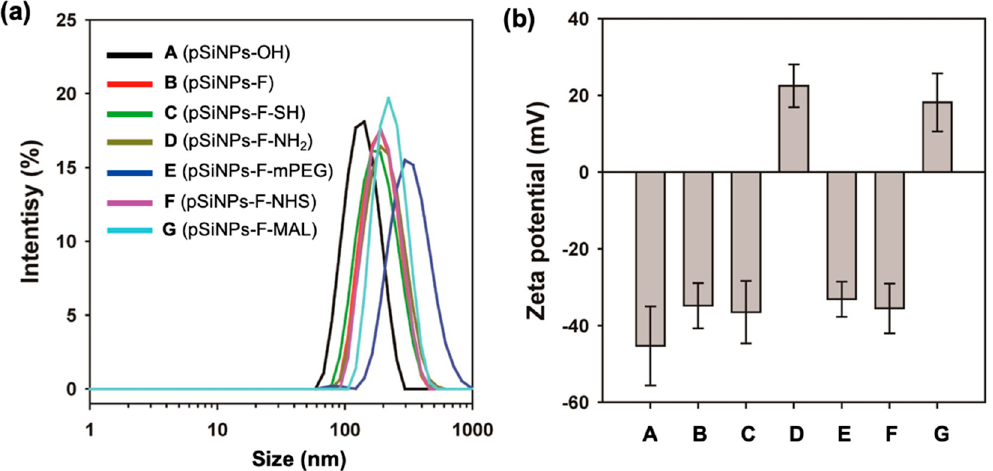
Figure 2. ( a ) Mean hydrodynamic diameter (intensity distribution) measured by dynamic light scattering (DLS), and ( b ) zeta-potential value of pSiNPs and its surface-functionalized samples. Each mean and standard deviation was calculated in triplicate. Table 1. DLS/PDI and Zeta-potential of the pSiNPs samples. 1 PDI: poly dispersity index.